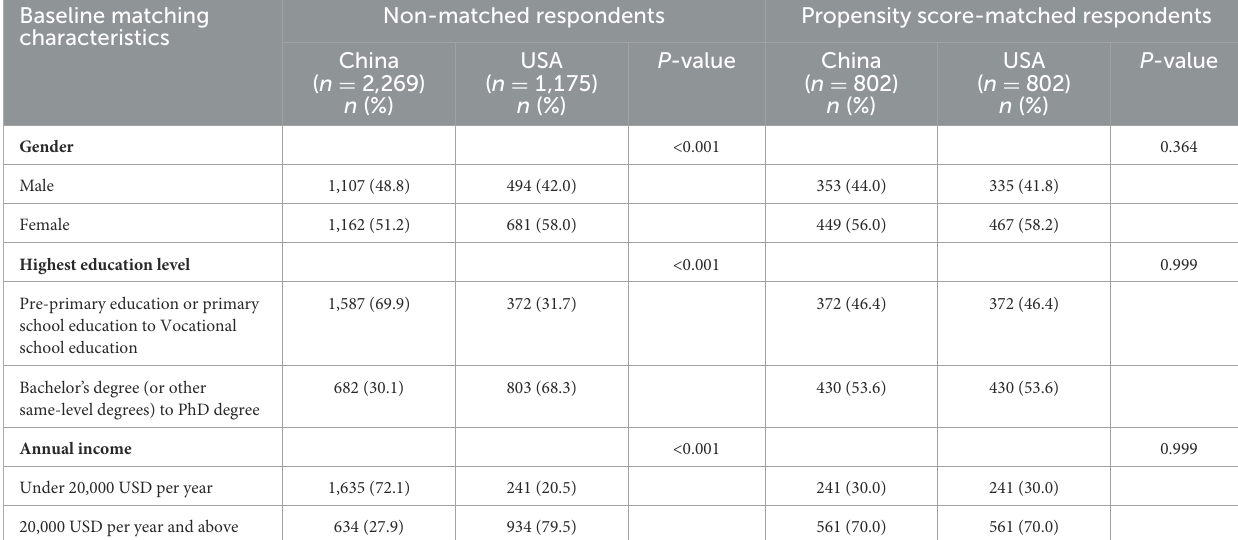
TABLE 3 Demographic characteristics of non-matched and propensity score-matched